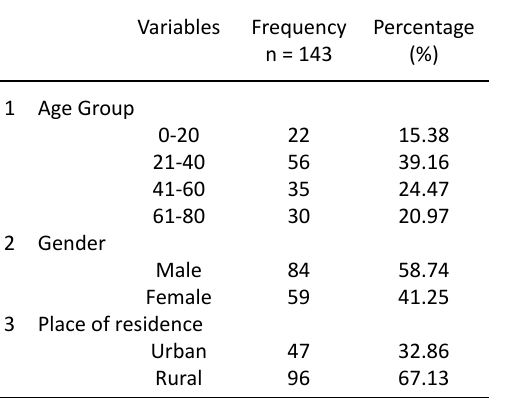
table 1. Demographic details of serum samples of febrile patients